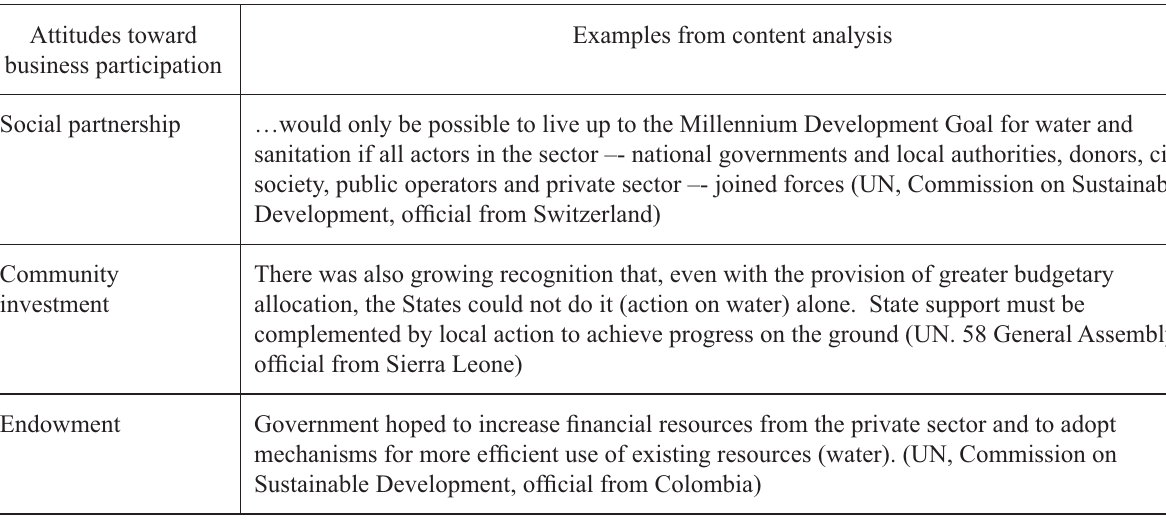
Table 5. Categorization of stakeholders’